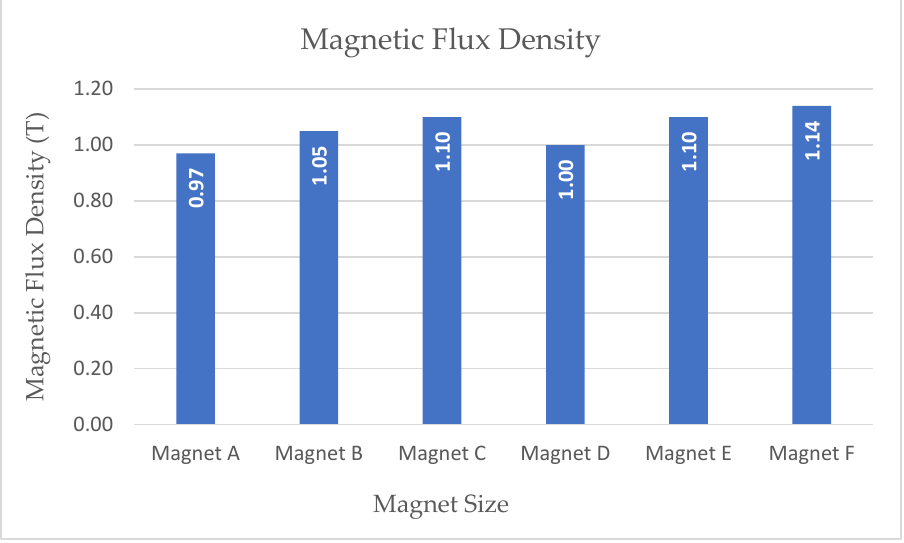
Figure 7. Magnetic flux density at the centre of the air gap region. Magnet C, Magnet E and Magnet F demonstrate an almost similar level of magnetic flux density. Out of three magnet sizes, Magnet E is chosen for this study as the electro- magnetic force is lower than Magnet F and the dimension is wider than Magnet C. Similarly, the T shape stator is analyzed by using the Magnet E by varying the air gap thickness. Figure 8 shows the electromagnetic force and magnetic flux density for T shape stator design.